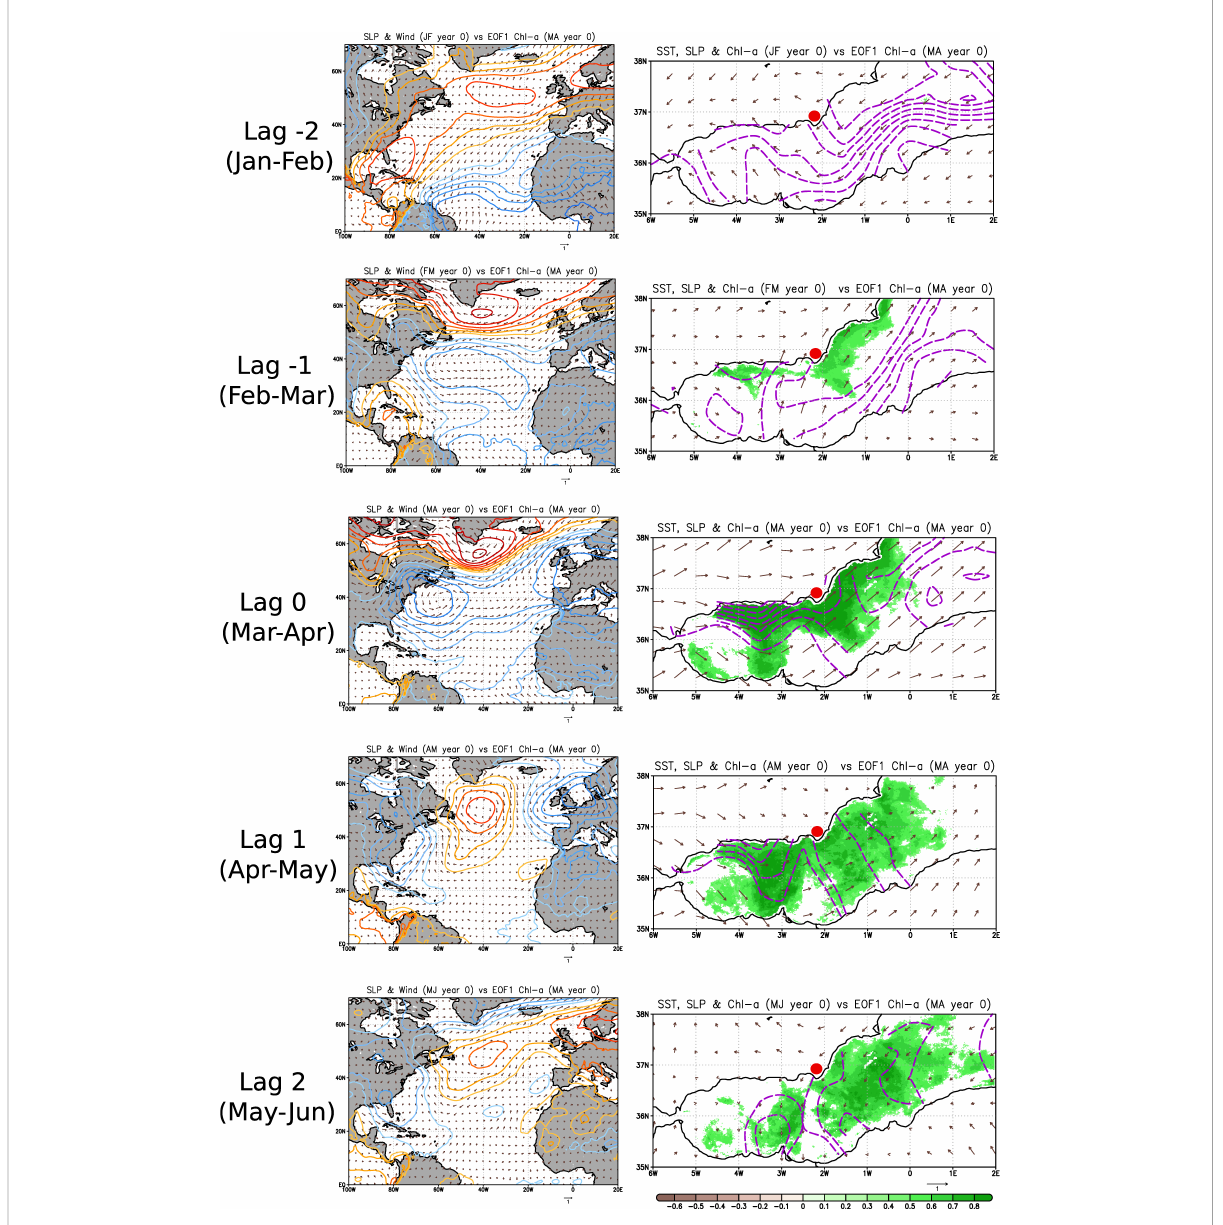
FIGURE 3 Regression maps, at different time lags, of the anomalous Chl-a variability mode calculated in March – April and within the nAS (PC1; see Figure 2C), onto 1) anomalous SLP (contoured with ci = 0.1 Pa; positive values in red colors and negative values in blue colors) and surface wind (vectors; unit in m/s) within the North Atlantic (left panels) and 2) anomalous SST (contoured; ci = 0.1 degrees), surface wind (vectors; unit in m/ s), and Chl-a (shaded; units in mg/m 3 ) within the Alboran Sea (right panels). Only those Chl-a anomalies which are statistically signi fi cant (p- values less than 0.05) based on a Student t-test are shown. For illustrative purposes, red point highlights the location of Cape